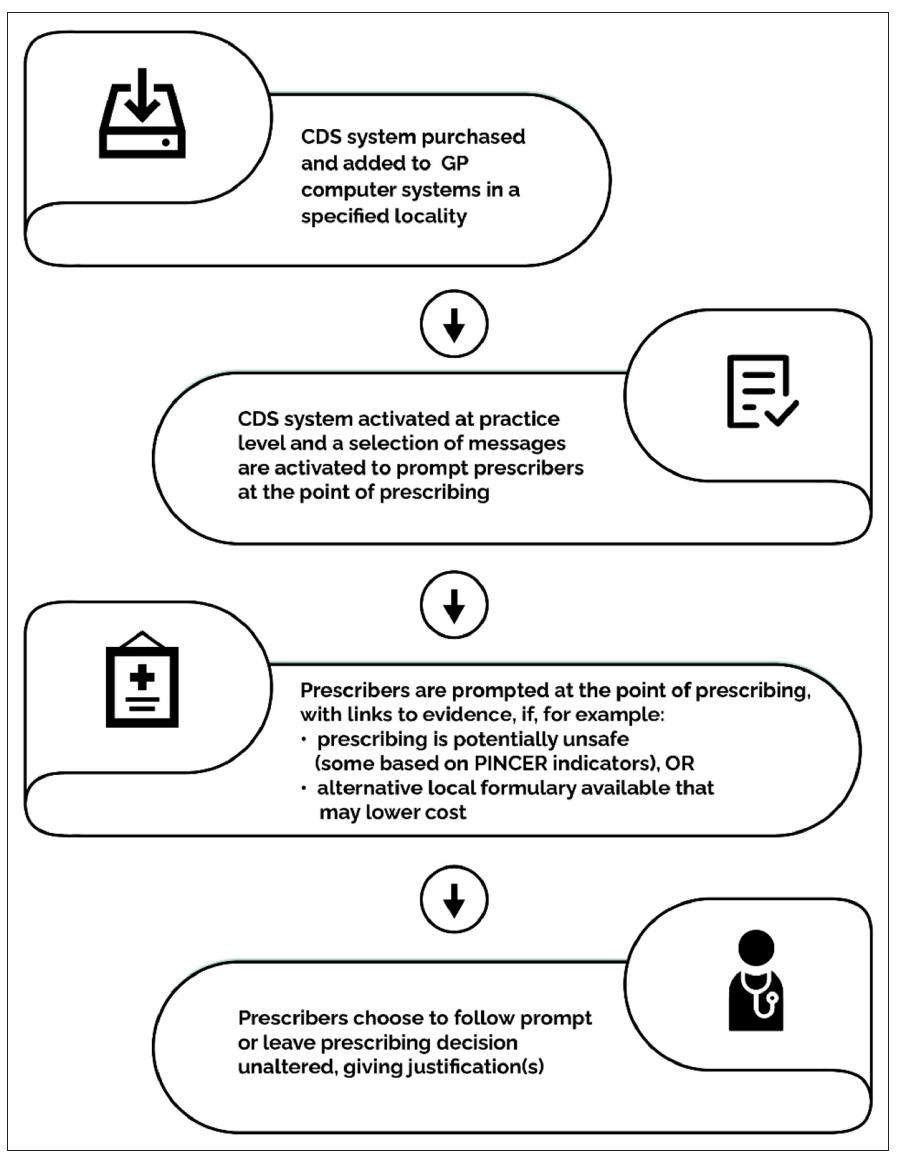
Figure 2 Summary of clincial decision support (CDS) interventions in general